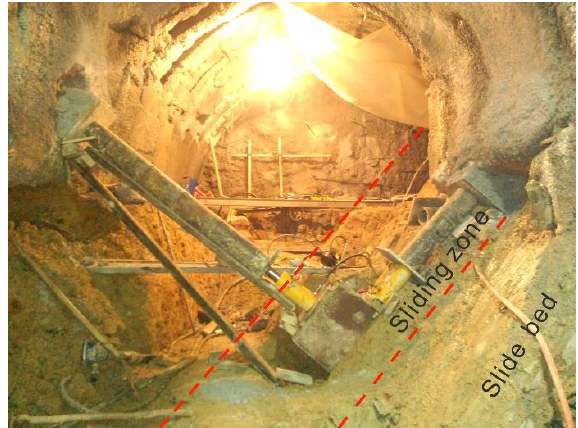
Figure 6. Full view of the installed apparatus of the in situ shear test in the testing tunnel of the Huangtupo landslide.